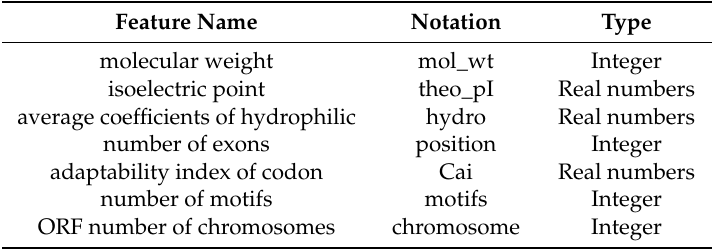
Table 4. The statistics of extra features in the S.C